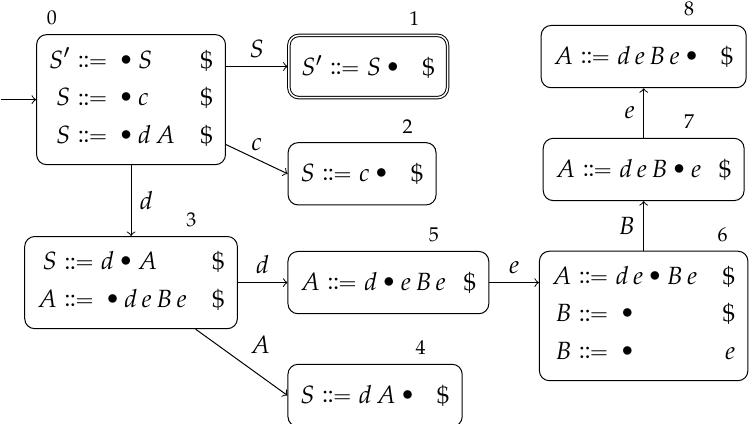
Figure 15. The handle-finding automaton for the specification Ξ in (4), constructed using G 1 .